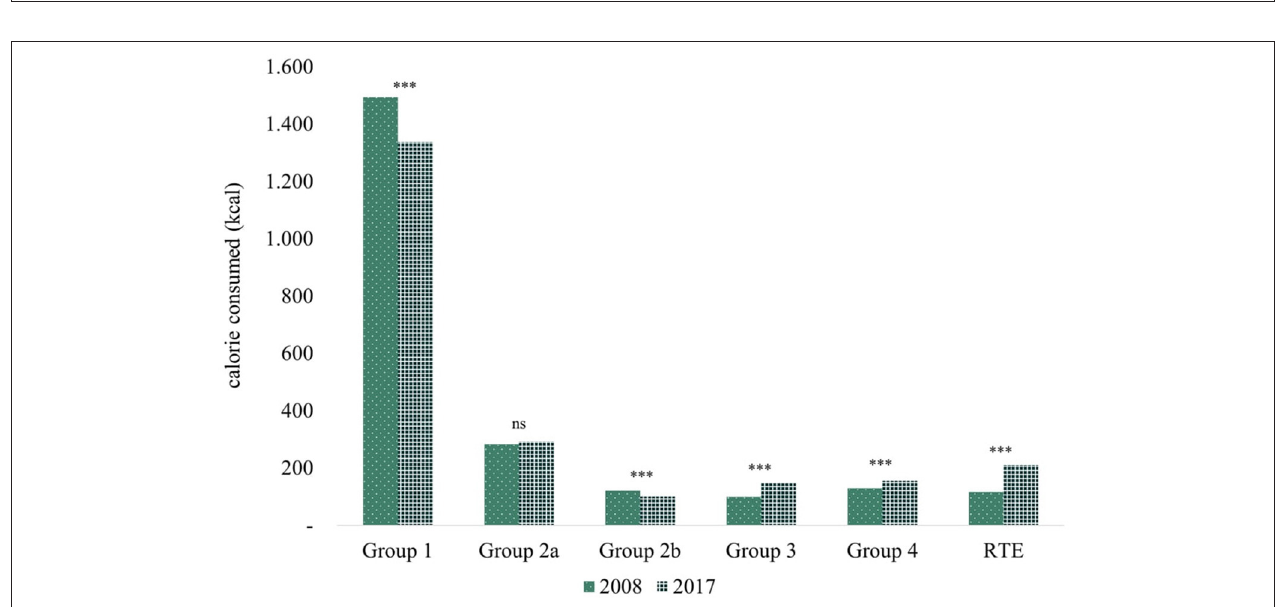
FIGURE 2 | Food consumption trends in West Papua Province, 2008–2017 a . a Measured as percent change of the food groups consumed in the West Papua province in 2008 and 2017; OAA, other aquatic animals; POH, processed-preserved-prepared-outside-home; F&B, food and beverages; SSB, sugar-sweetened beverages; bev, beverages; ns, not significant; ***shows a statistical significance at < 0.001, **at 0.001–0.01, and *at < 0.05.